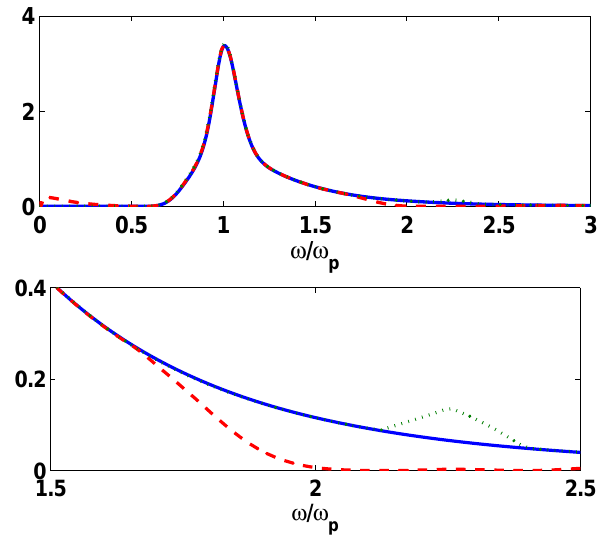
Fig. 5. Top: The original Jonswap spectrum (solid), the free-wave Jonswap spectrum without bound waves (dashed), and the free- wave spectrum with nonlinear contributions (dotted). Bottom: The zoomed version.